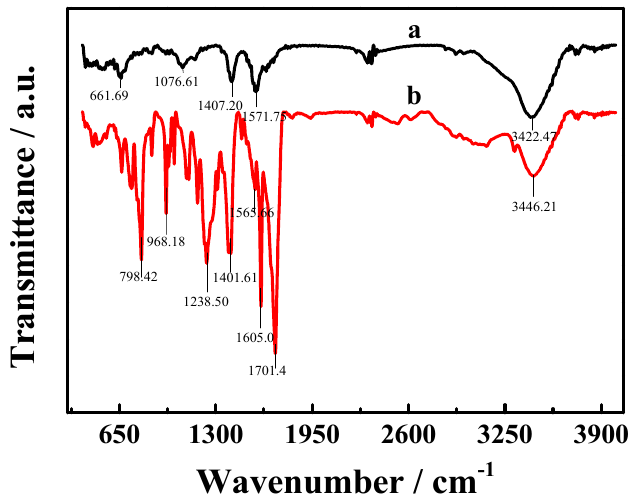
Figure 2. The Fourier-transformation infrared (FT-IR) spectra of TCPP–Gr (a) and TCPP (b).